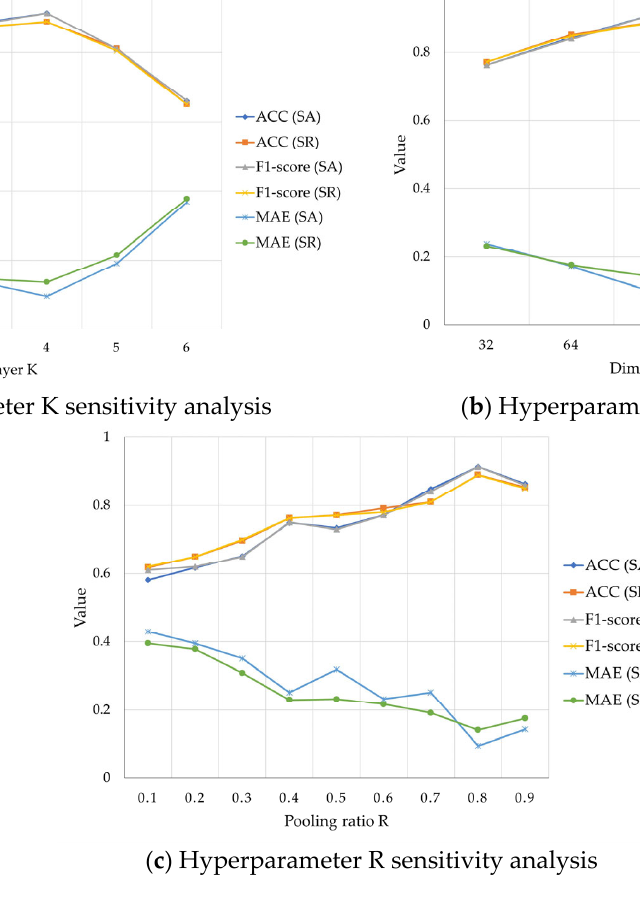
Figure 10. Network parameter sensitivity analysis.